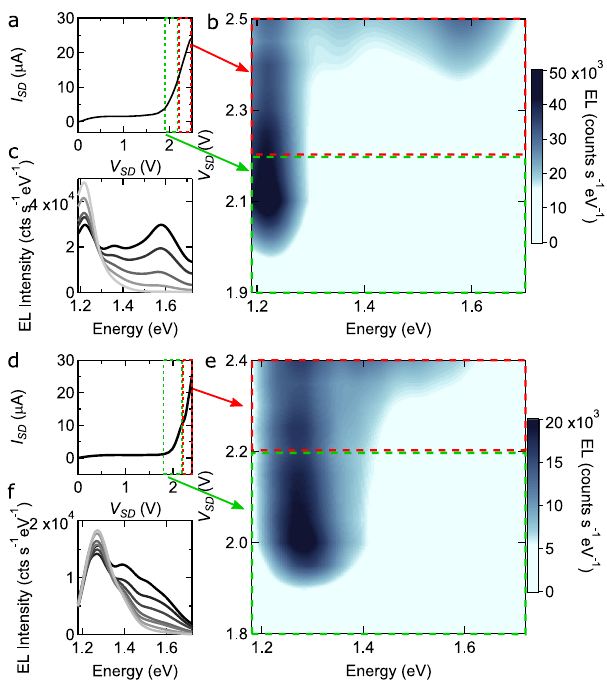
Fig. 5 Bias-tunable light emission from vdW interface LEFETs. a Output characteristics of the 2L-WS 2 /4L-InSe device, whose data are shown in Fig. 3 ( V G = + 0.2 V). The colored dashed lines delimit the low-bias (green line) and high-bias (red line) regime, which exhibit different EL spectral properties. b Color plot of the EL spectrum as a function of photon energy and V SD . In the low-bias regime (region inside the green rectangle) EL exhibit a single peak, due to a Γ – Γ interlayer transition from the bottom of the InSe conduction band to the top of the WS 2 valence band (see Fig. 3). In this regime the spectrum is independent of bias. In the high-bias regime (region inside the red rectangle), the EL spectrum evolves upon increasing V SD , showing that the LEFET acts a light source with bias-tunable spectrum. c Individual EL emission spectra measured in the high-bias regime, upon varying V SD from 2.3 to 2.5 V. d – f Same measurements as those shown in panels a – c , but performed on a 2L-MoS 2 /5L-InSe LEFET (data taken at V = – 0.7 V). The data illustrate that the evolution of the EL spectrum G observed in this MoS 2 /InSe LEFET is fully analogous that observed in the WS 2 /InSe LEFET, showing the robustness of the device operation.